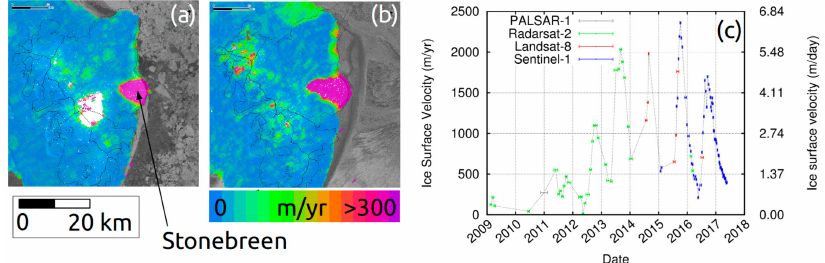
Figure 7. Ice surface velocity maps for Stonebreen on Edgeøya (Svalbard) from Sentinel-1 data of the time periods 21/01/2015 to 02/02/2015 ( a ) and 27/02/2017 to 11/03/2017 ( b ) and time-series of velocity close to the front from 2009 to 2017 ( c